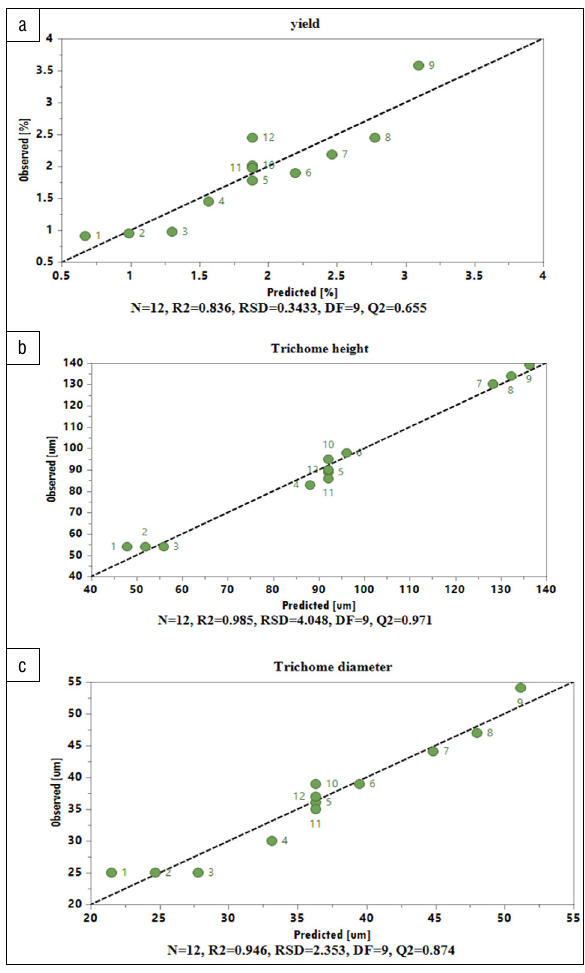
Figure 1: The linearity of the predicted versus observed values plots for (a) yield, (b) trichome height and (c) trichome diameter of Lippia javanica .